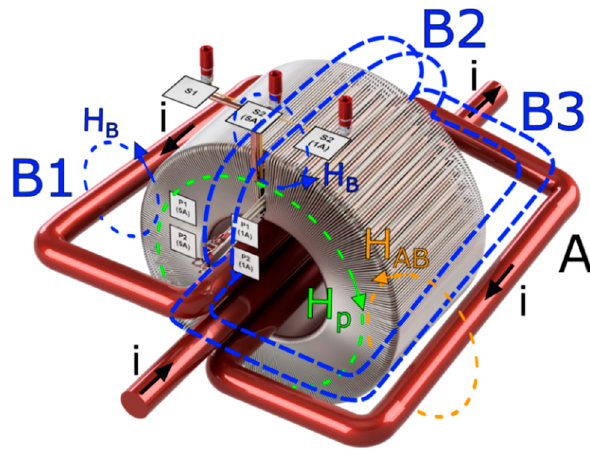
Figure 14. 3D view of designed wideband CT with 3 turns of primary wire led through the window of the magnetic core.